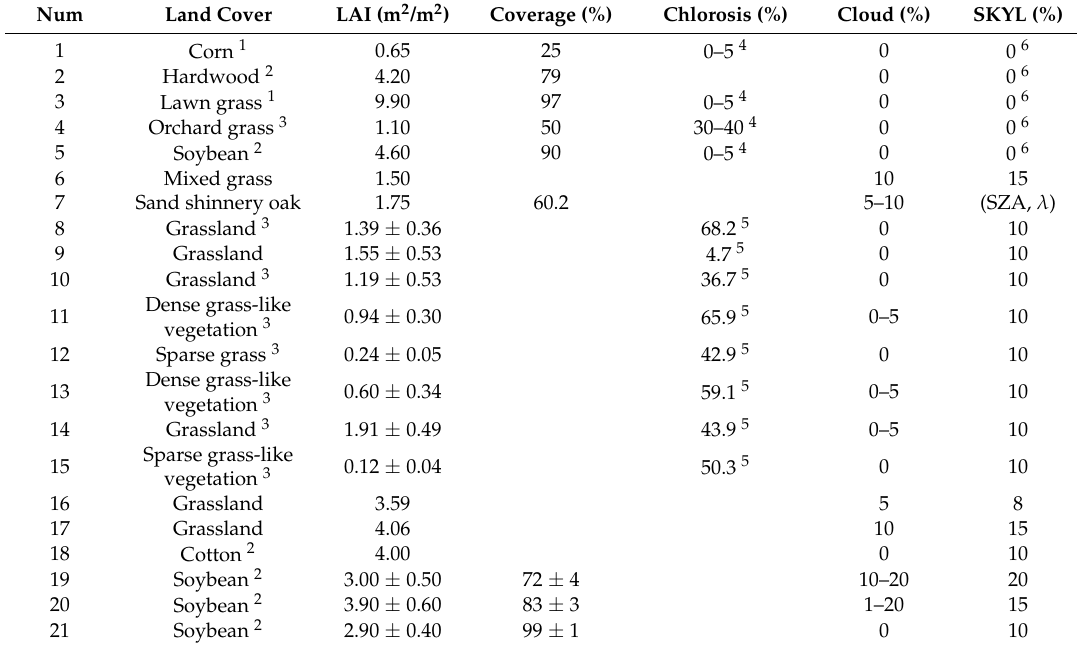
Table 2. The description of the 21 sets of BRDF field